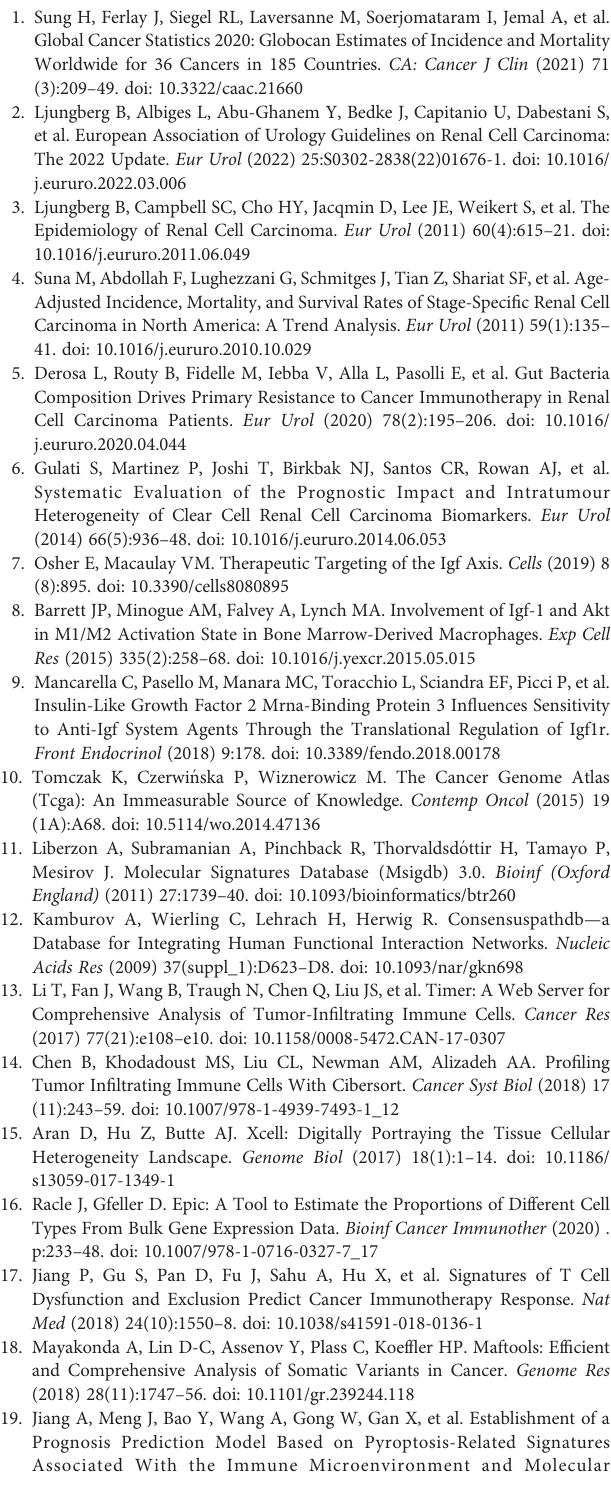
Supplementary Table 4 | List of discovered small-molecule drugs that could be used as potential drugs for the treatment of